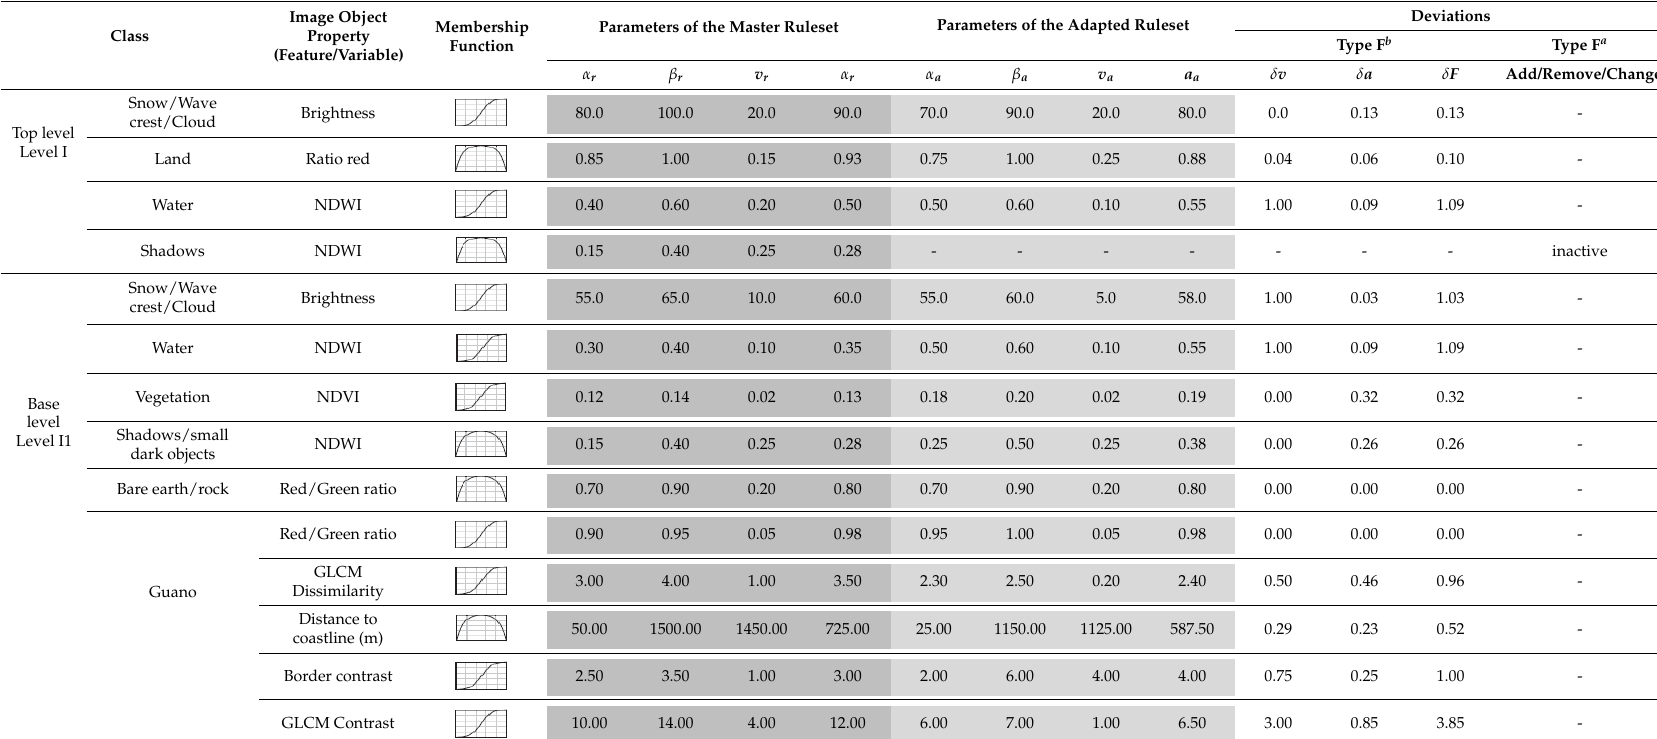
Table 5. Ruleset adaptation from HOPE to BAIL.